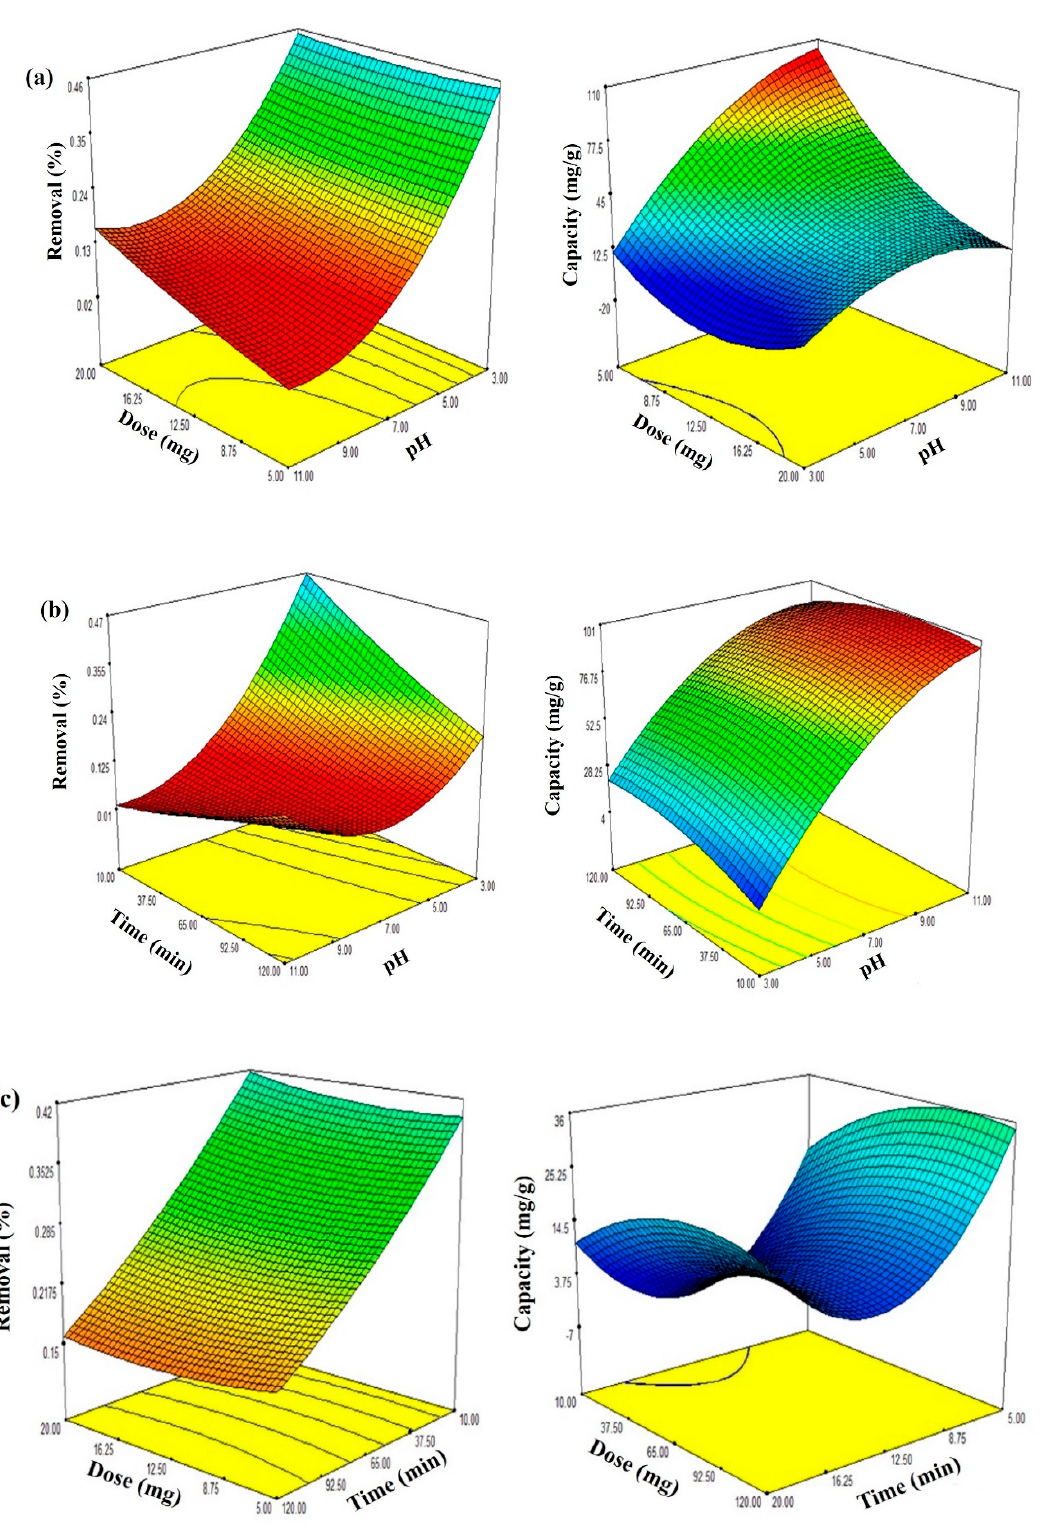
Figure 9. Surface response plots for the effects of ( a ) pH and hybrid CNTs dose, ( b ) pH and contact time, and ( c ) hybrid CNTs dose and contact time.